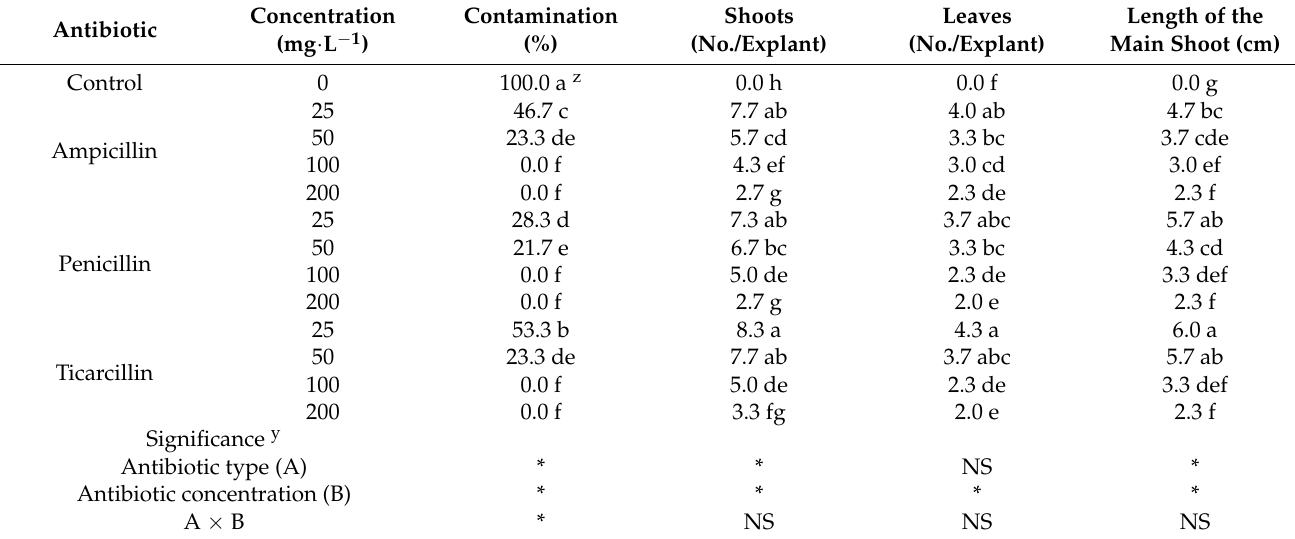
Table 2. Effect of ampicillin, penicillin and ticarcillin, on contamination percentage, multiplication and growth of banana ‘Grand Naine’ shoots after 6 weeks in